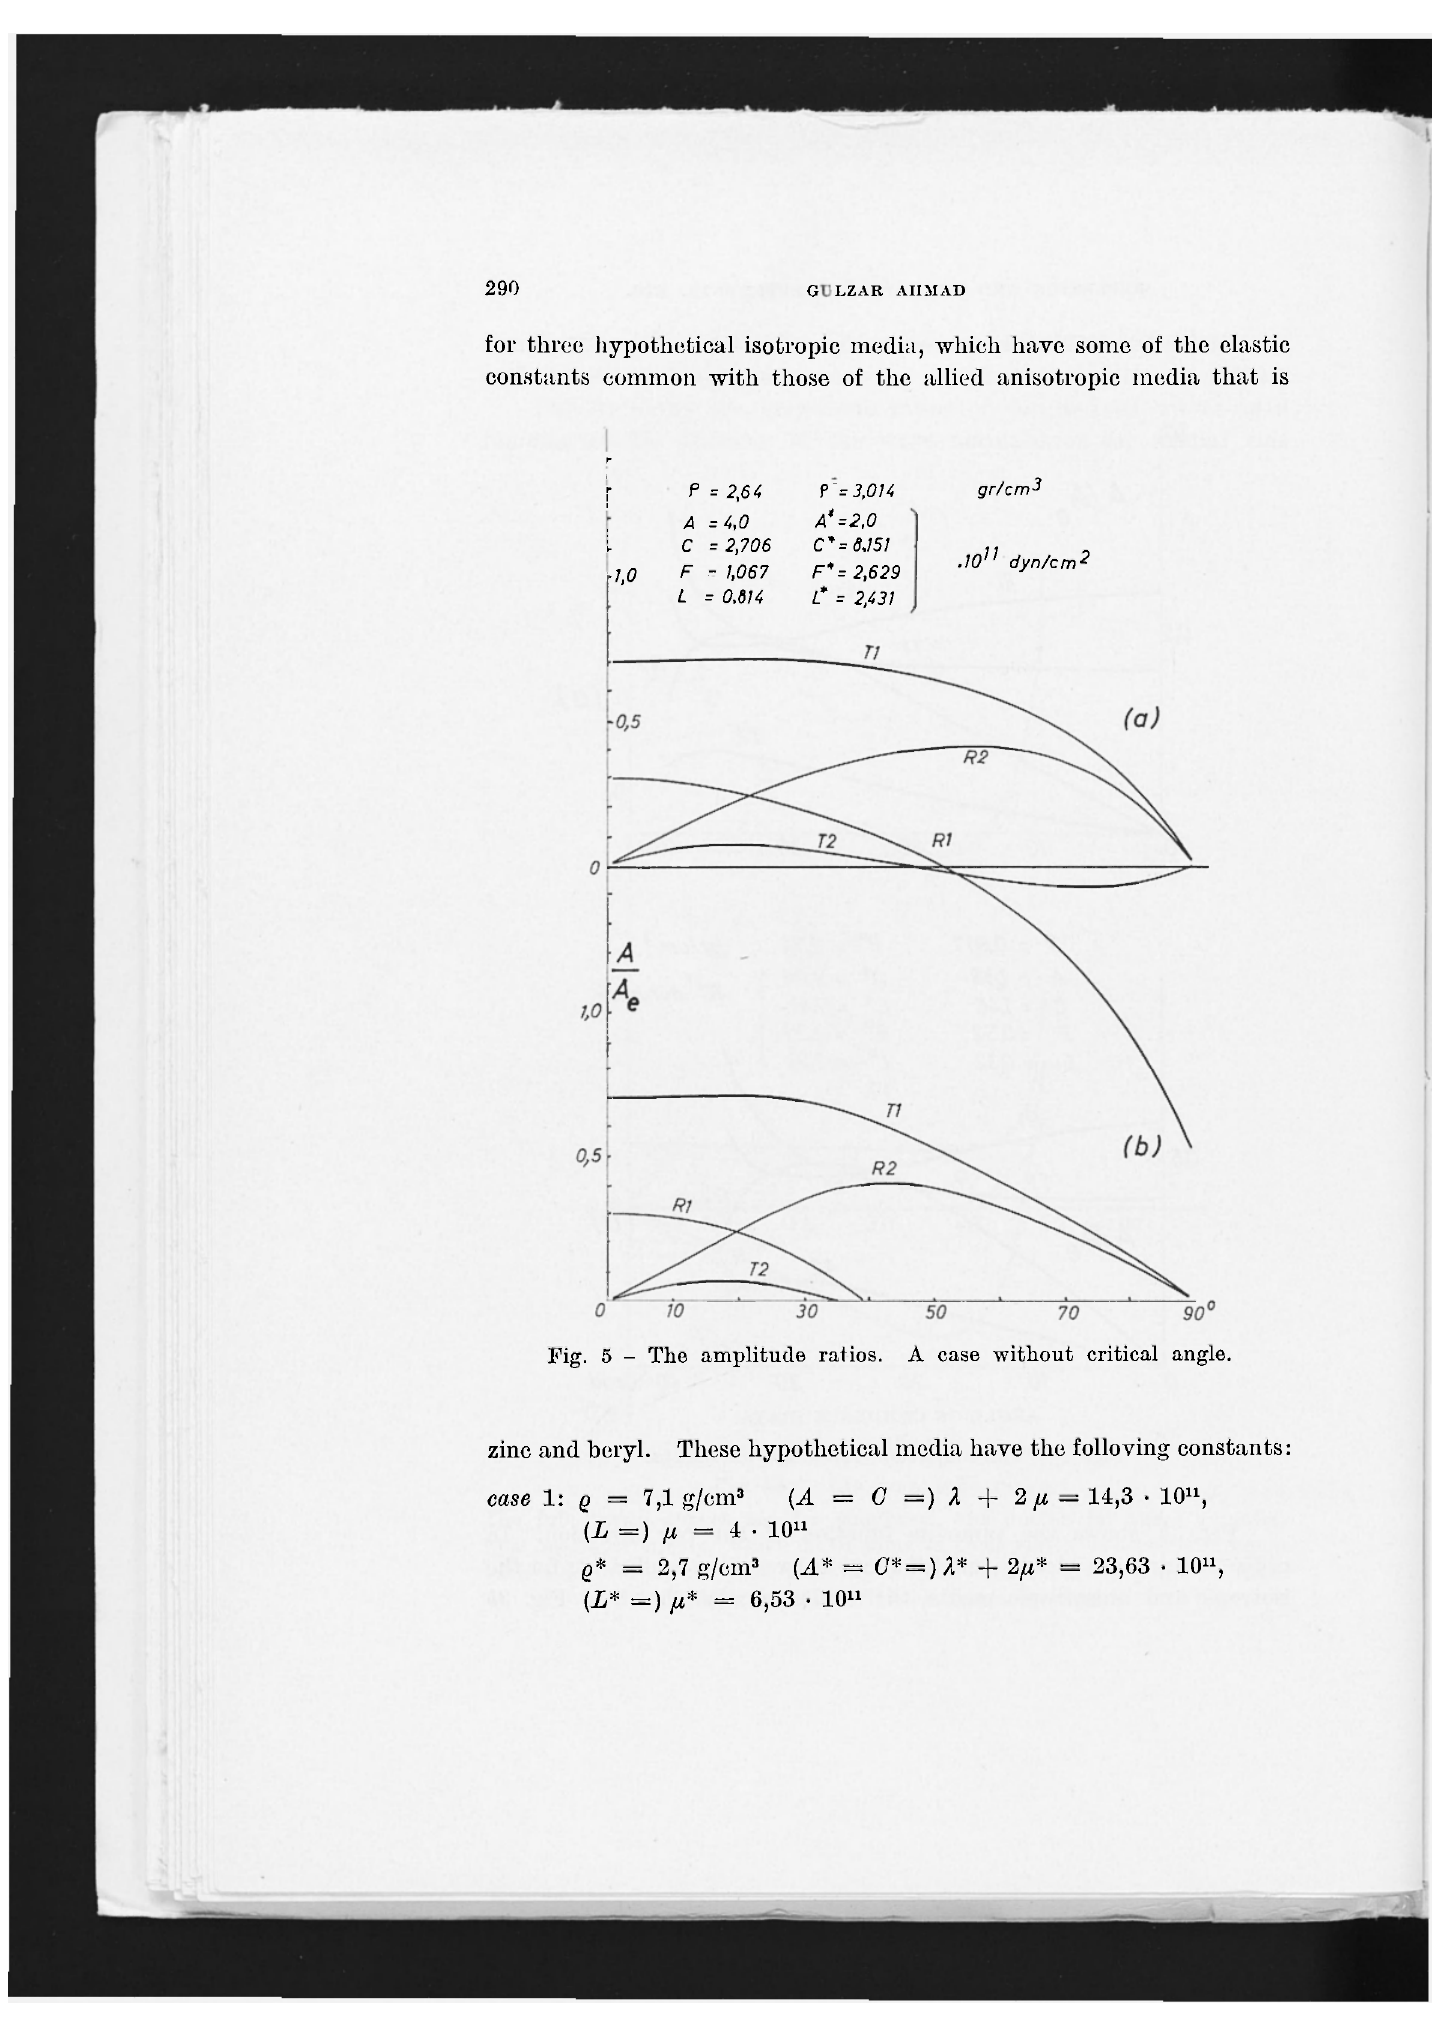
Fig. 5 - The amplitude ratios. A case without critical